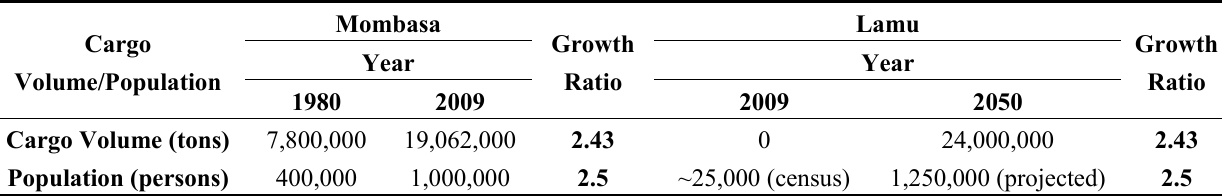
Table 2. Correlation between port cargo volume and population in Mombasa and the projection of port cargo volume and population in Lamu based on the growth rate ratio of the Mombasa port. The growth ratio is the rate of change of cargo volume and populations over time.